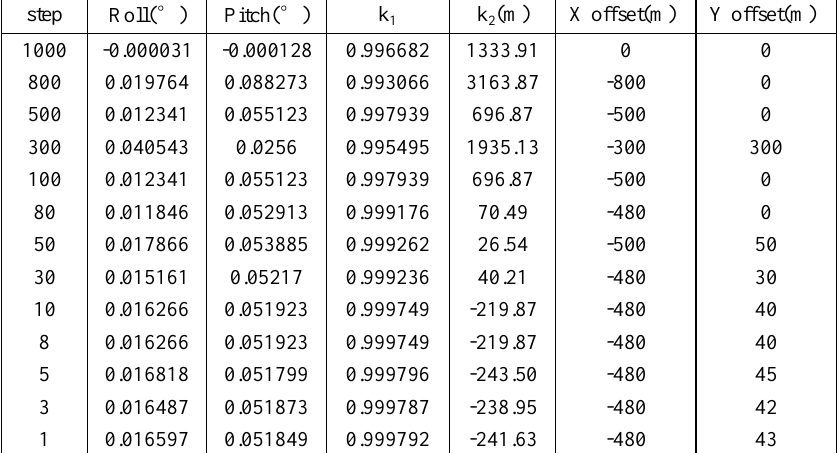
Table 5. Comparison of calibration parameters at different step size.